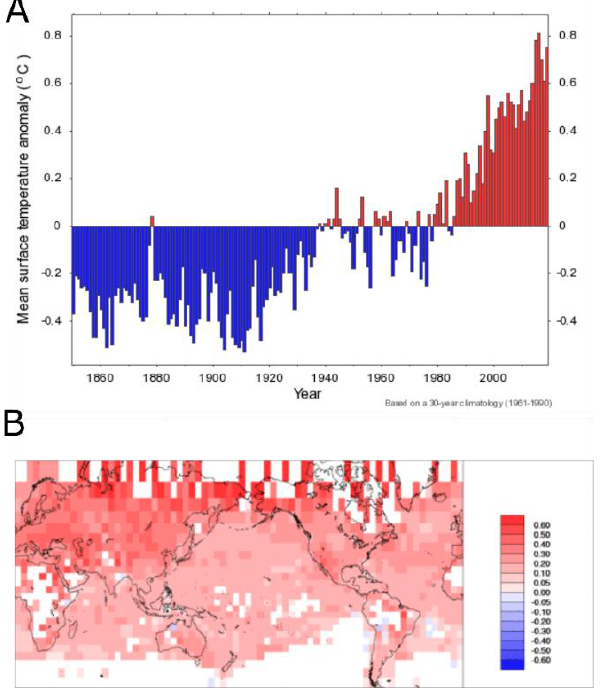
Figure 1. Global climate variability. ( A ) Time series graph of global mean surface temperature anomalies ( ◦ C) (1850 to 2019). The current international standard of a 30-year average from 1961 to 1990 was used as the long-term average. Blue bars indicate cooler-than-average years; red bars show warmer-than-average years. ( B ) Trend map in global annual temperature ( ◦ C/10 years) from 1970 to 2019. White means little to no change, while red shows places that warmed, and blue shows places that cooled. The time series and trend analyses use the Climatic Research Unit HadCRUT4 global gridded (5 × 5 degree resolution) temperature data set [8]. Source: Australian Government Bureau of